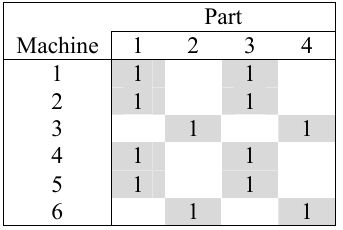
Fig. 1. Initial machine-part incidence matrix The block diagonalization problem aims at minimizing the number of 1s in the off-diagonal blocks as well as the number of 0s in the diagonal blocks by rearranging rows and columns of matrix A. In the ideal situation the solution is a perfect block diagonal matrix that the number of 1s in the off-diagonal blocks and the number of 0s in the diagonal blocks are equal to zero (See Fig. 2). This implies the minimum intercellular movements and the maximum utilization of machines.